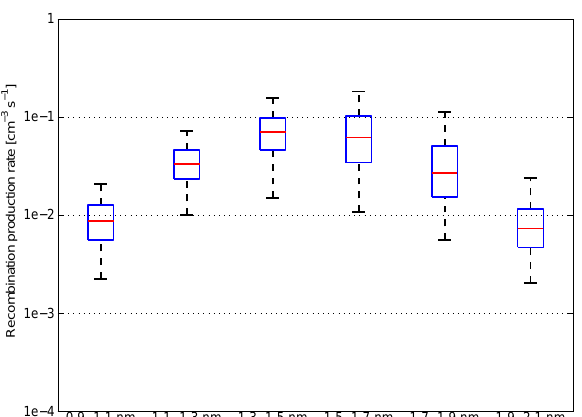
rates were obtained in the smallest (0.9–1.1 nm) and